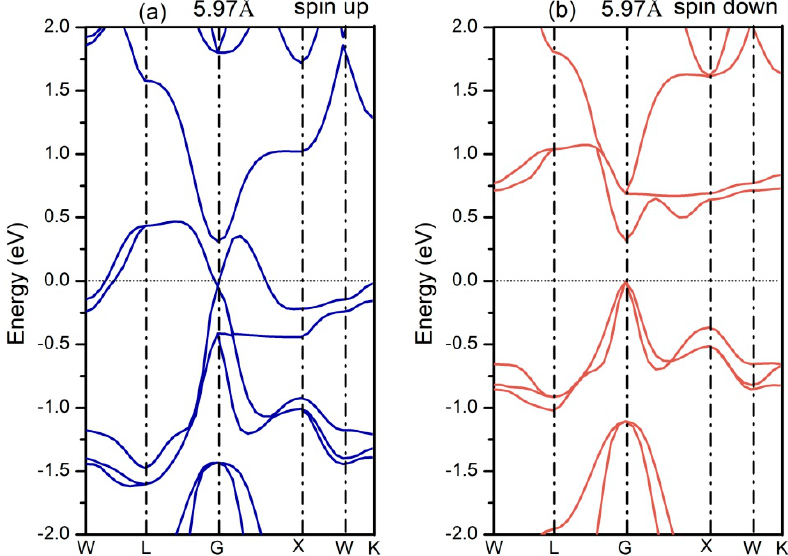
Figure 4. Band structures of the ( a ) spin-up and ( b ) spin-down channels of the ScFeRhP EQH compound at its equilibrium lattice constant.